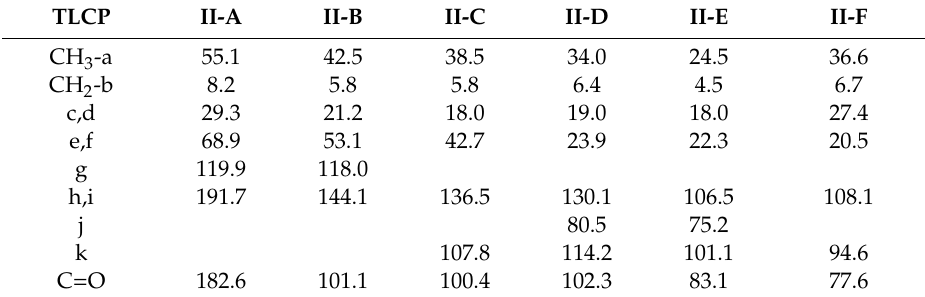
Table 6. Spin-lattice relaxation time T 1 ρ (ms) in the rotating frame for each carbon in the TLCP-II series at room temperature.